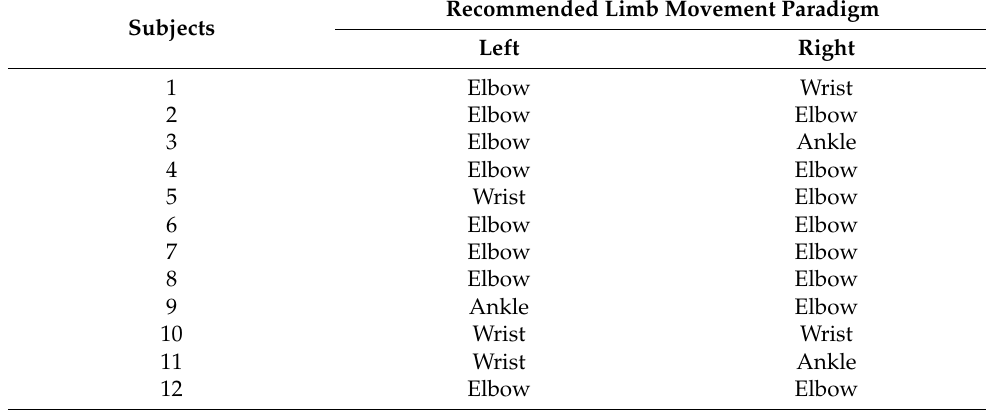
Table 2. Recommended paradigms from user proficiency for motor